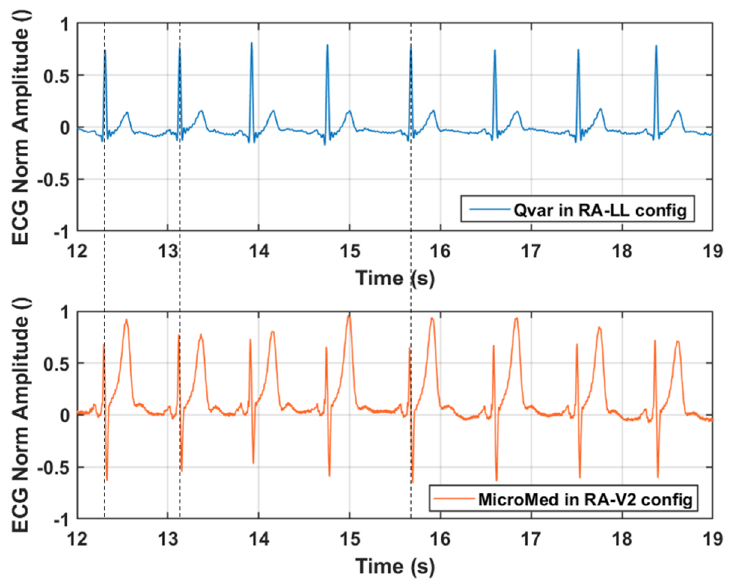
Figure 13. ECG trace acquired simultaneously from Qvar and MicroMed systems, from different derivations. Dashed lines show the R−peaks correspondence between the two tests.